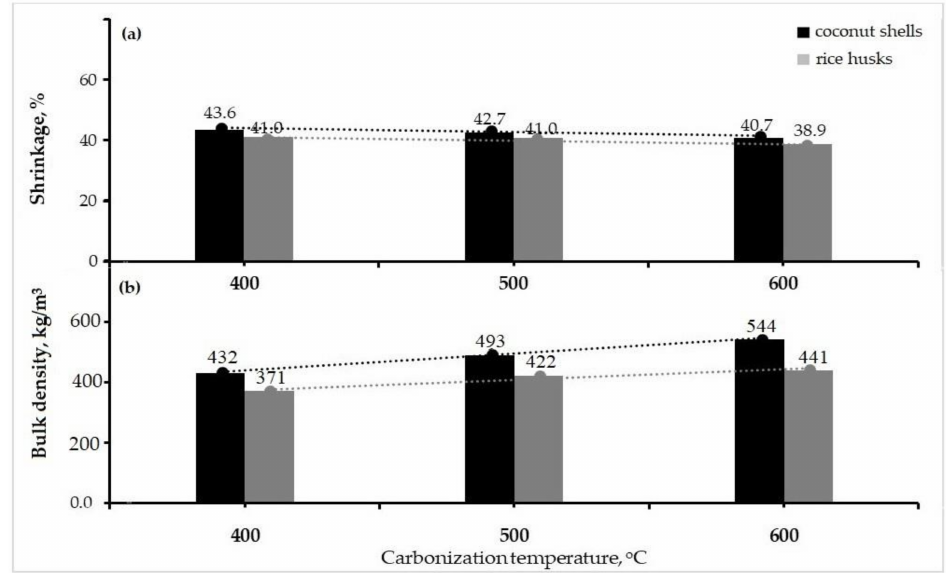
Figure 7. ( a ) Mass shrinkage and ( b ) bulk density of biocoke briquettes at optimal composition as a function of carbonization